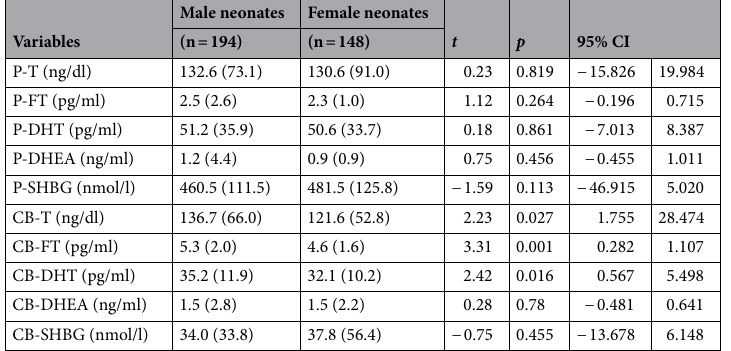
Table 1. Comparisons of prenatal androgens and cord blood androgens between male and female neonates. P-T prenatal testosterone, P-FT prenatal free testosterone, P-DHT prenatal dihydrotestosterone, P-DHEA prenatal dehydroepiandrosterone, P-SHBG prenatal sex hormone binding globulin, CB-T cord blood testosterone, CB-FT cord blood free testosterone, CB-DHT cord blood dihydrotestosterone, CB-DHEA cord blood dehydroepiandrosterone, CB-SHBG cord blood sex hormone binding globulin.